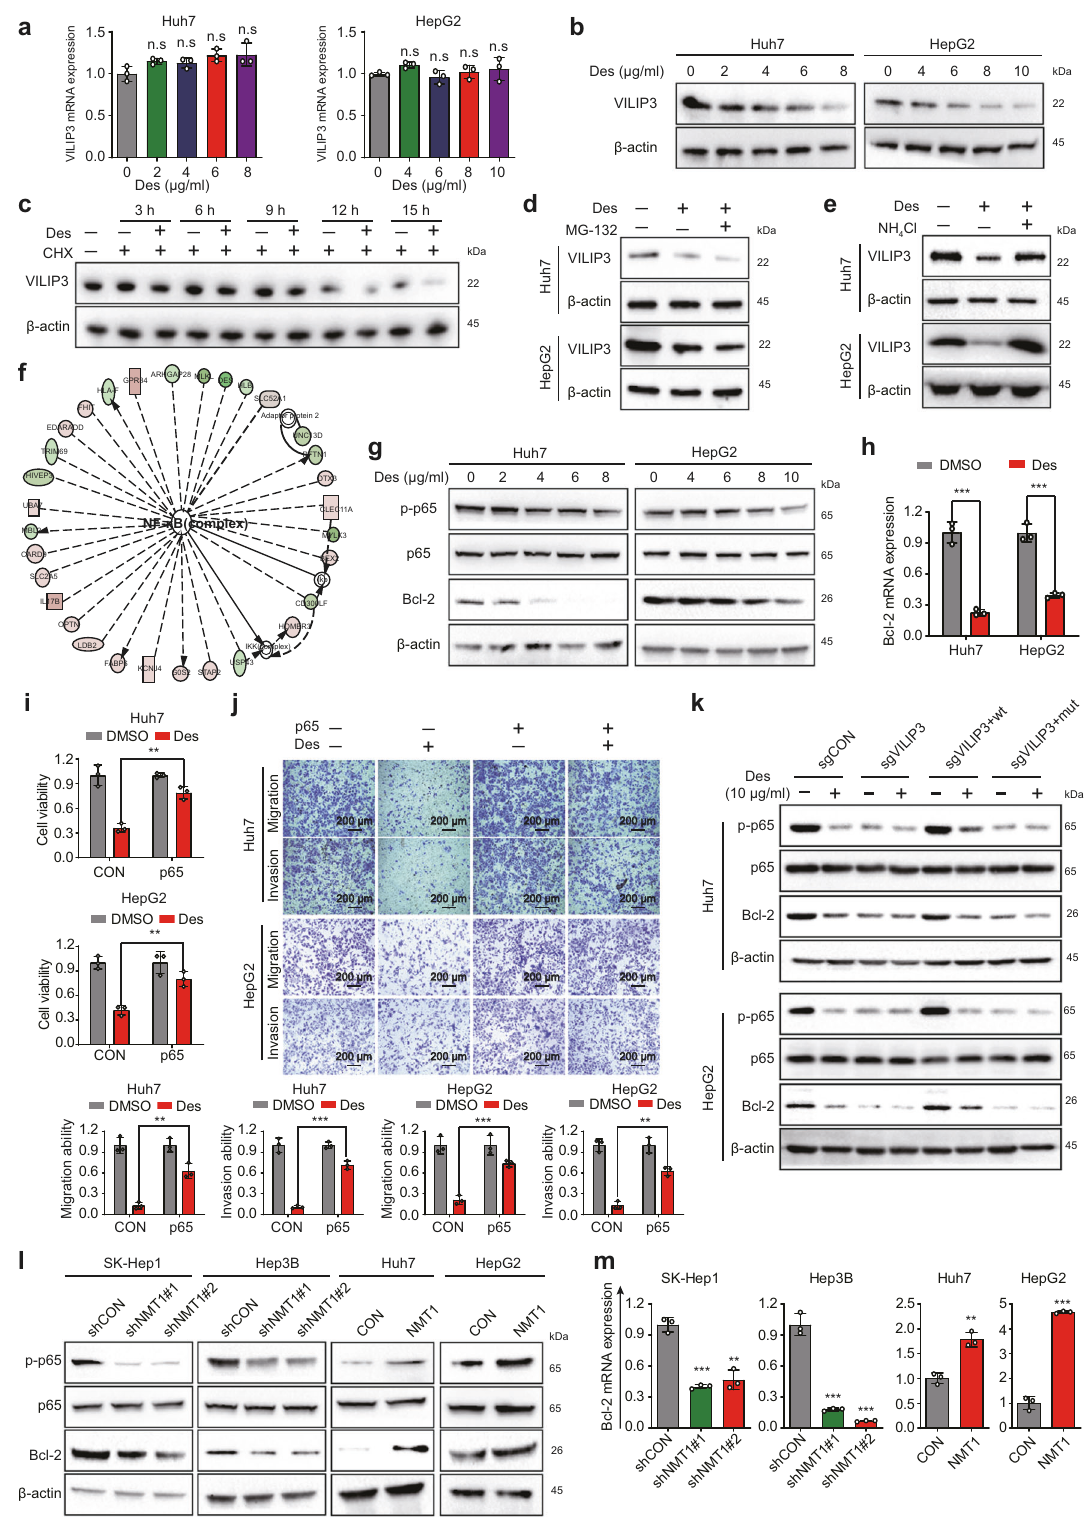
Cell cycle analysis Cell cycle assay was conducted as described in a previous study. 48 Cells in different groups were harvested, washed with PBS and fi xed with 75% ethanol for 2 h. After staining with PI/RNase solution for 15 min in the dark, cell-cycle pro fi les were determined using fl ow cytometry (BD Biosciences, Bedford, MA,